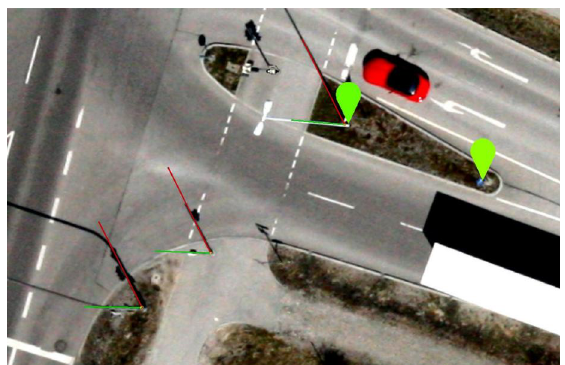
Figure 2. Principle of pole detection – 3K left looking image, red lines: detected shadows, green lines: detected poles, green drops: nearby SAR